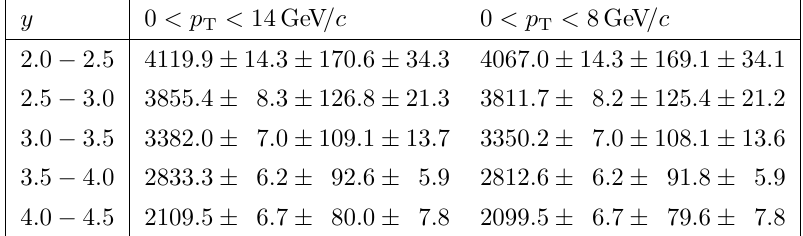
[nb per unit rapidity] for prompt J/ψ d y